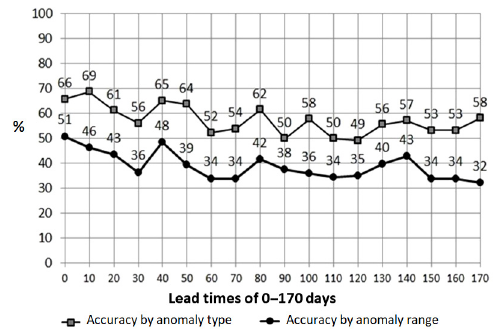
Figure 5. The same as Figure 3 for seasonal (three-month mean) air temperature spatial anomaly